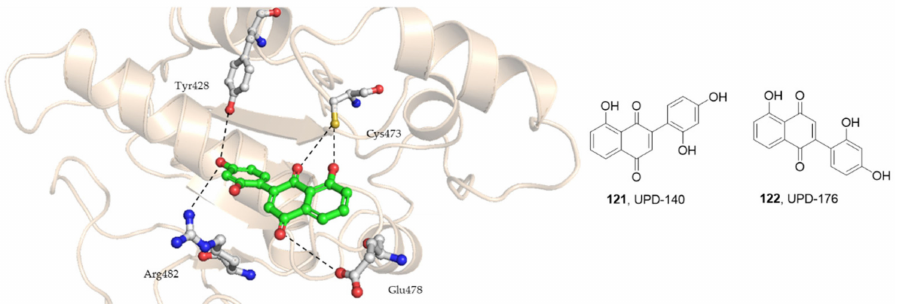
Figure 13. The chemical structures of 121 , 122 , and the docking of UPD-140, 121 into the Cdc25B catalytic